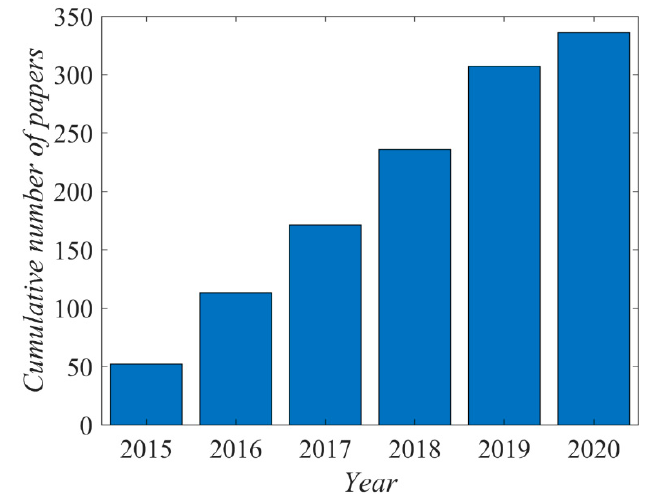
Figure 1. The cumulative number of scientific papers published since 2000.